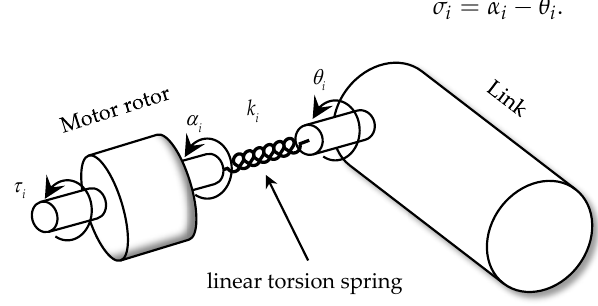
Figure 2. Schematic of the joint